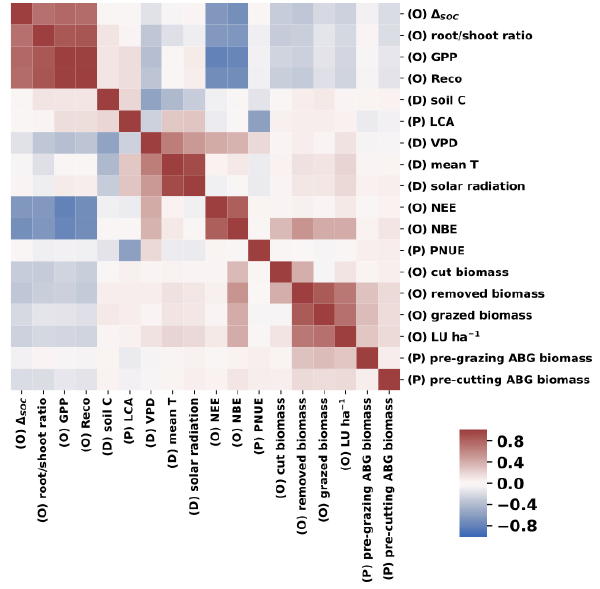
Figure 8. Heatmap of correlation coefficients ( r ) between annual mean meteorological model drivers (D), selected model parameters (P) and annual mean MDF predictions (O).